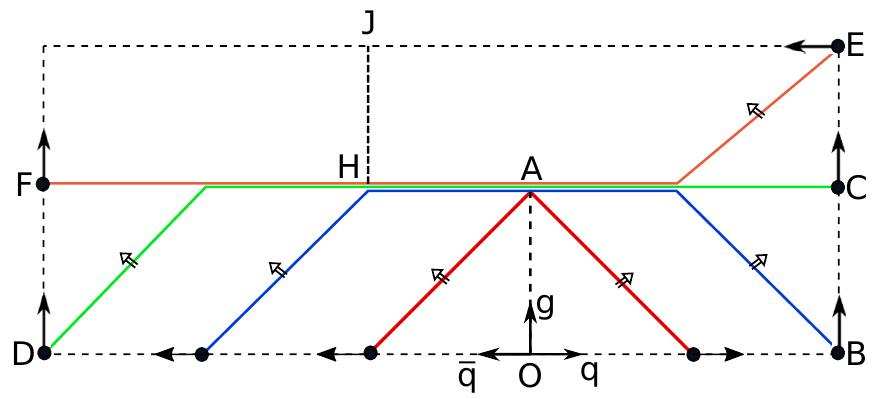
Figure 3 . A q − g − ¯ q system moving out from a single point O with energies 2, 2, and 3 units of energy respectively. The position of the string is shown at four consecutive times, marked by red, blue, green, and purple colour